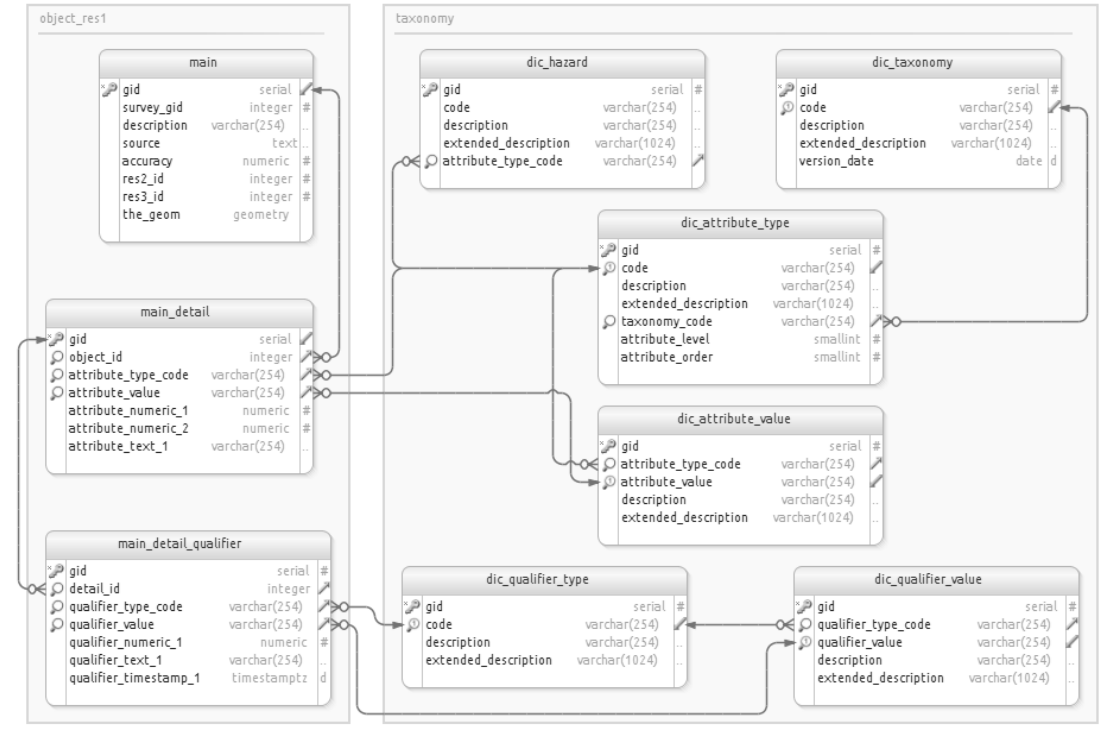
Figure 2. Database model prototype, with object schema ( left ) and taxonomy schema ( right ).